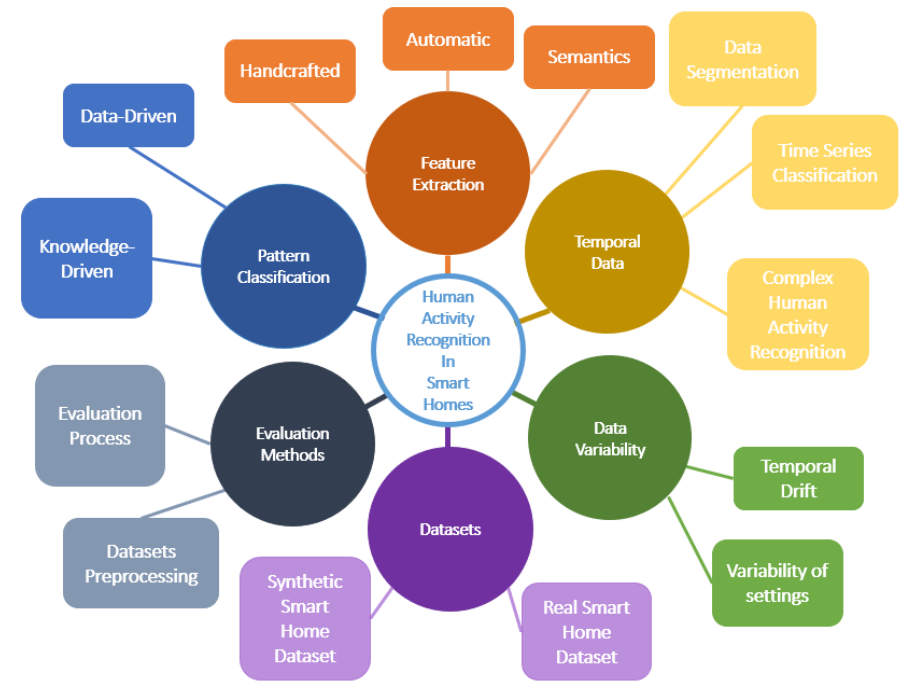
Figure 2. Challenges for Human Activity Recognition in smart